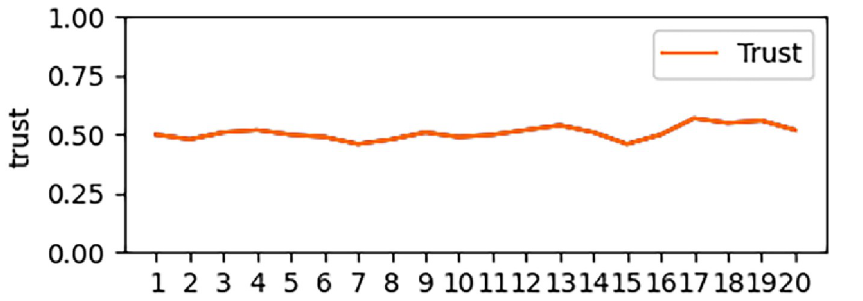
Fig 5. Changes in trust levels between default trust values.